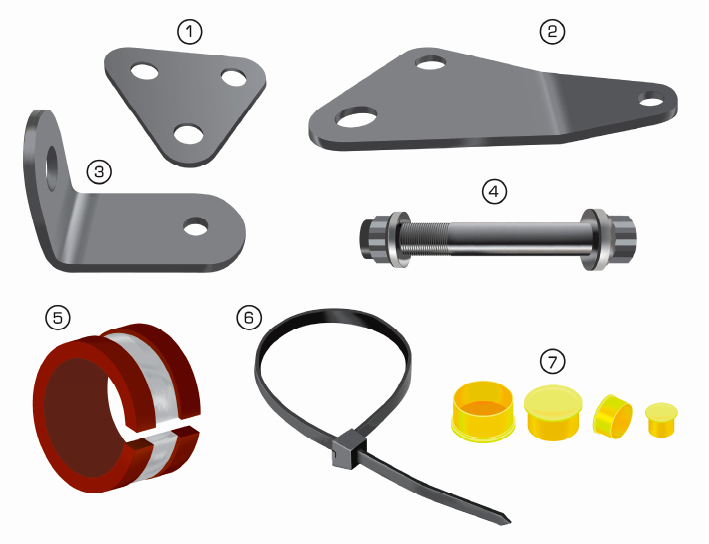
Figure 4. Parts used in the assembly tasks: (1) bracket A, (2) bracket B, (3) bracket C, (4) nut and bolt, (5) cushioned loop clamp, (6) tie-wrap and (7) cap covers.